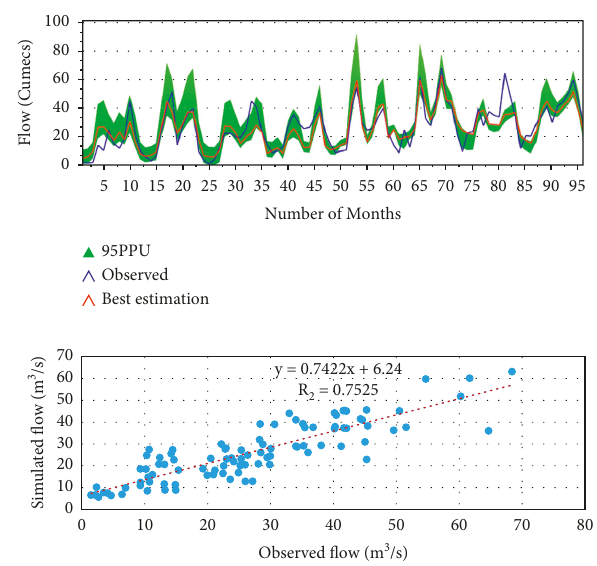
Figure 10: Scatter plot and monthly validated flow hydrograph at the Awata